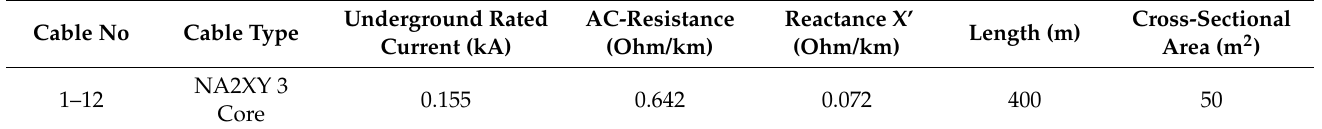
Table 4. Cable characteristics for network 3.